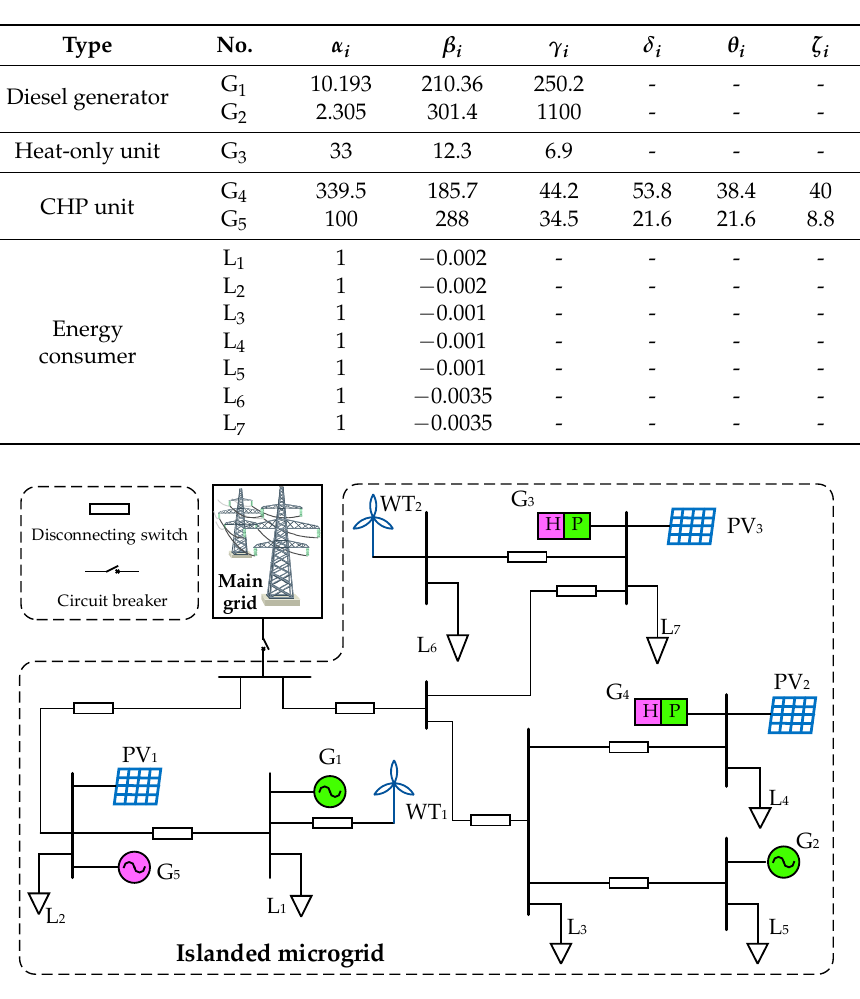
Figure 7. Physical topology of the testing islanded microgrid.